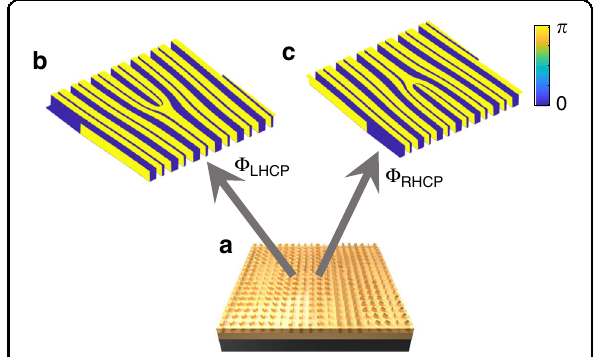
Fig. 1 Schematic of off-axis polarization control based on spin- independent phase modulation. a Device for off-axis polarization control. b , c Phase response of LHCP and RHCP